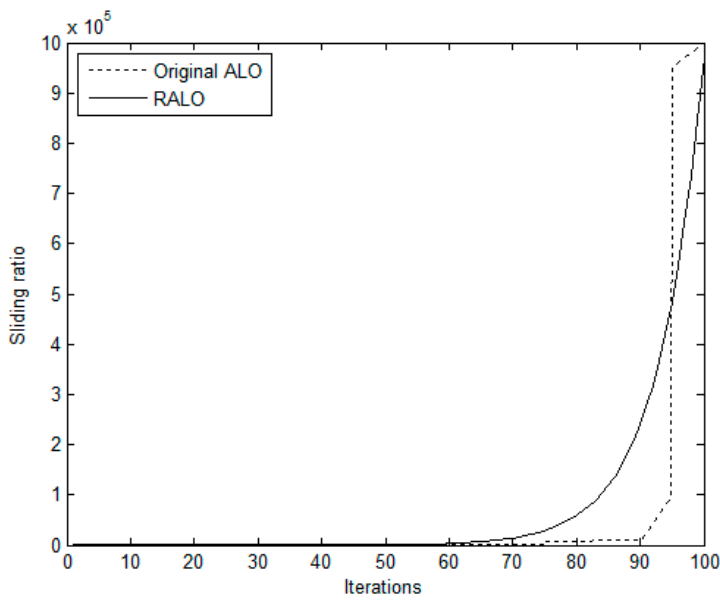
Figure 6. Cuves of α and w along with iterations.